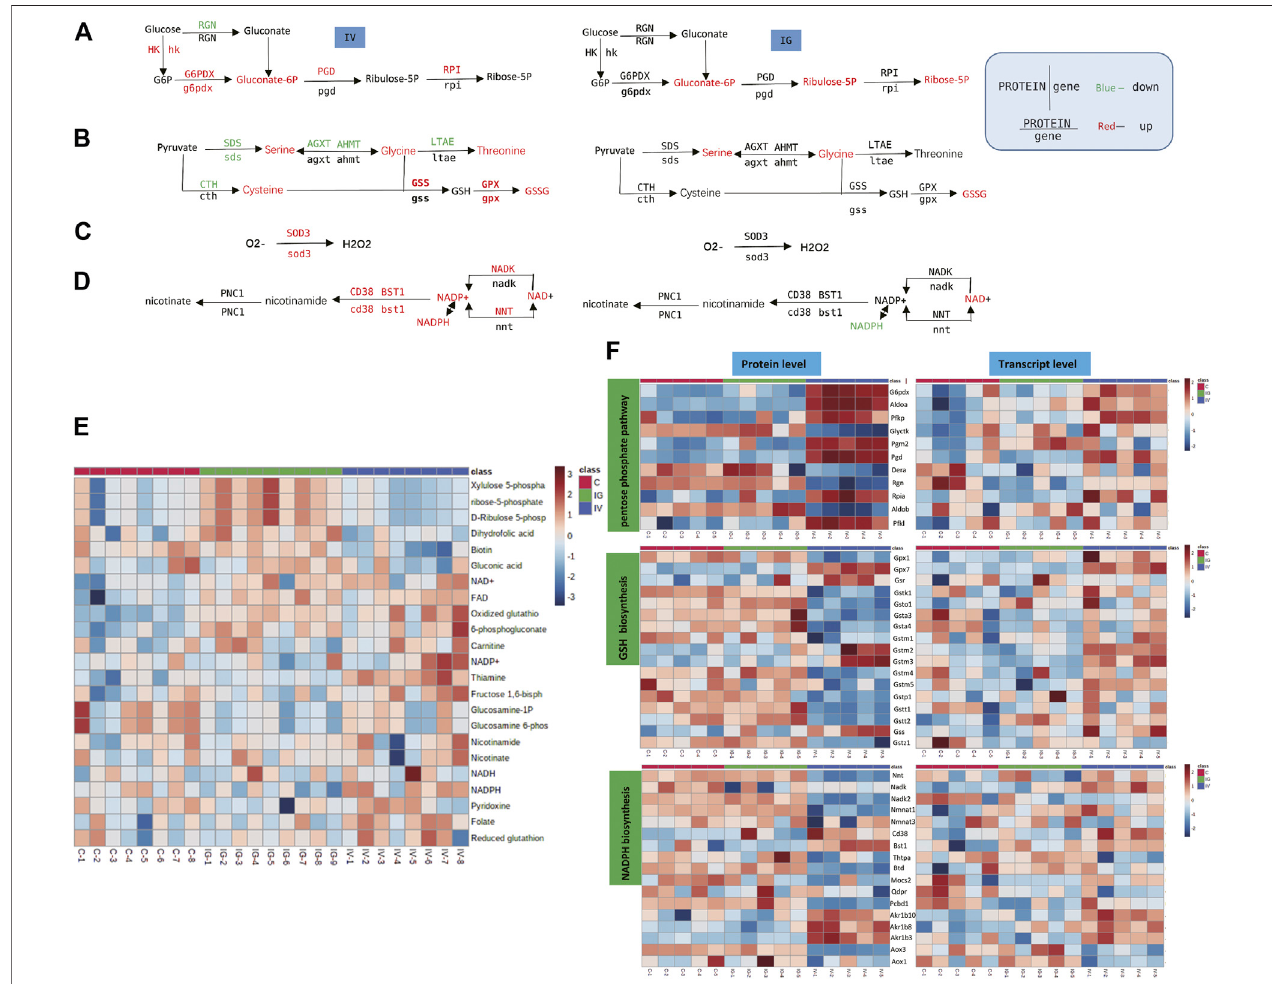
FIGURE6| EffectofMesoporousSilicaNanoparticles (MSNs) onthe antioxidant pathway based ondifferentroutes ofadministration (IVand IG). (A – D) Schematic of PPP, glutathione biosynthesis, SOD3 antioxidation and NADPH biosynthesis. Red indicates signi fi cant upregulation, and green indicates signi fi cant downregulation. (E) Heatmap of metabolite concentrations of PPP, glutathione and NADPH biosynthesis. (F) Heatmaps of PPP, glutathione and NADPH biosynthesis based on proteomics and transcriptomics.